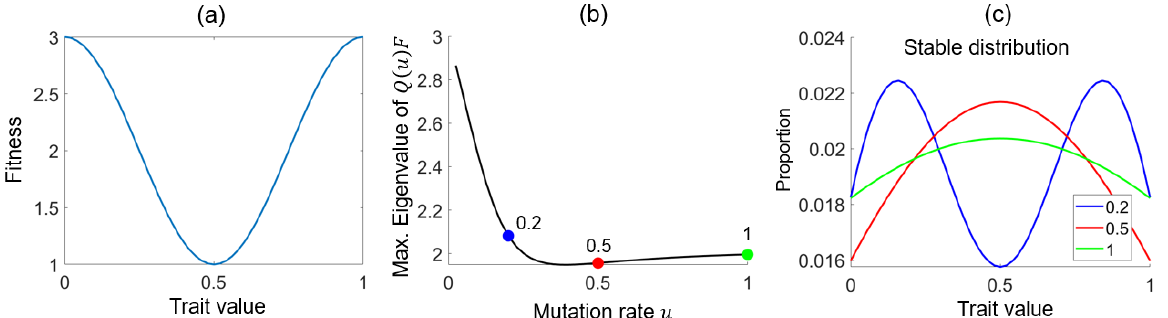
Figure 3. When fitness is maximal near the boundaries, for example f ( x ) = cos ( 2 π x ) , shown in ( a ), accumulation near the endpoints can lead to increase fitness with mutation rate, seen by the increase in ( b ). In ( c ), we see that for intermediate mutation rates, the distribution has a peak in the center. This decreases with a larger mutation rate, increasing the overall fitness. These results are derived in the truncation model, though this effect is more pronounced when accumulation is used.